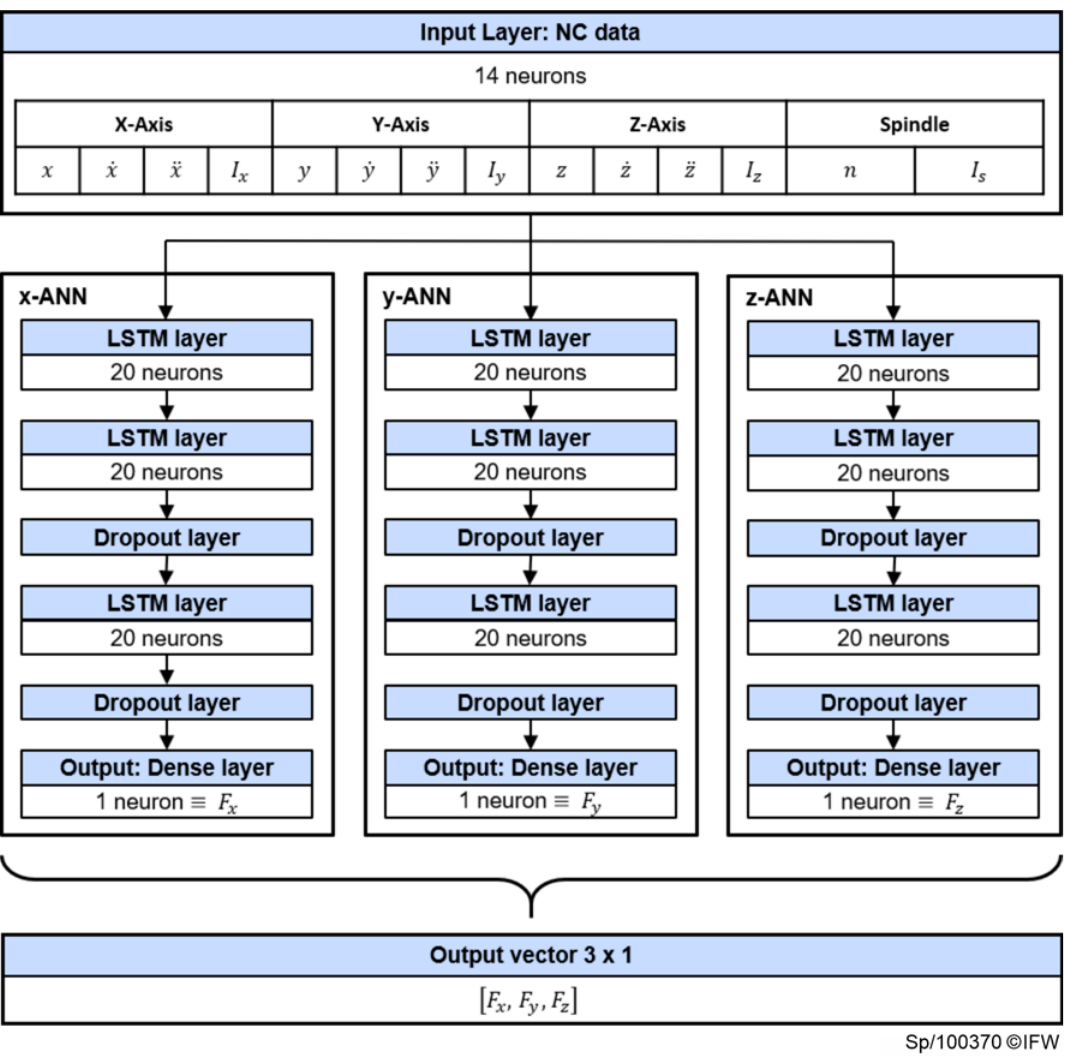
Figure 3. Schema of the long short-term memory neural network (LSTM) neural network.